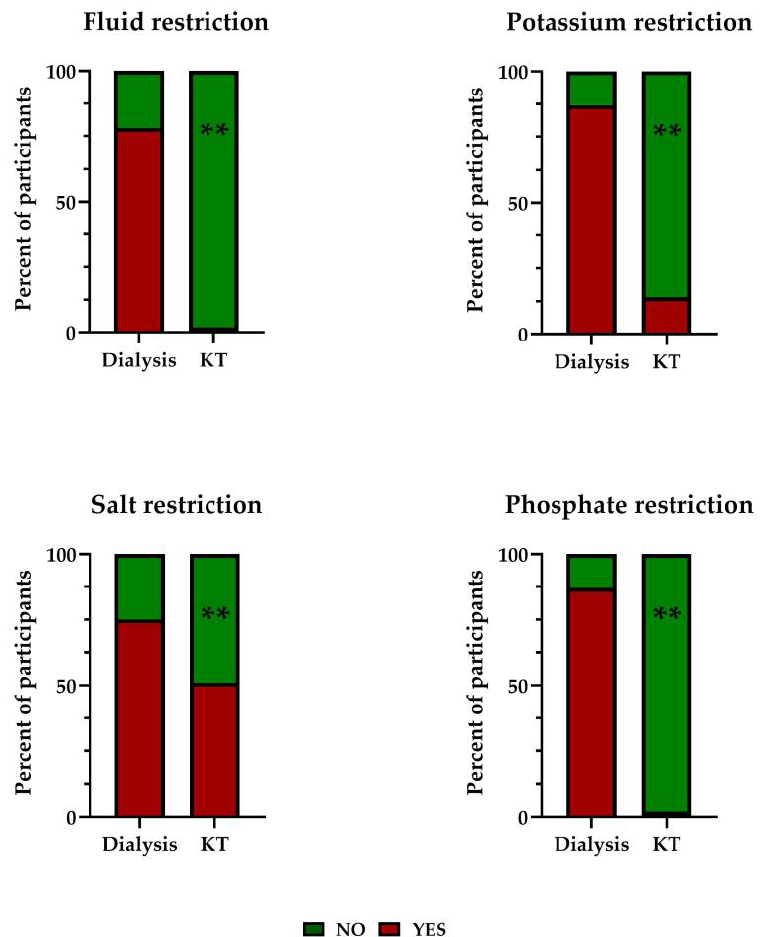
Figure 2. Proportion of participants reporting restrictions in fluid, potassium, salt, or phosphate intake. ** p < 0.001 vs. the dialysis group. KT, kidney transplant. In participants on dialysis, the MEDI-LITE score did not differ among individuals of different sex ( p = 0.590), age ( p = 0.715), or BMI ( p = 0.901) categories, from northern, central, or southern Italy ( p = 0.408), by the level of education ( p = 0.103), working status ( p = 0.296), or level of physical activity ( p = 0.266) (Figure